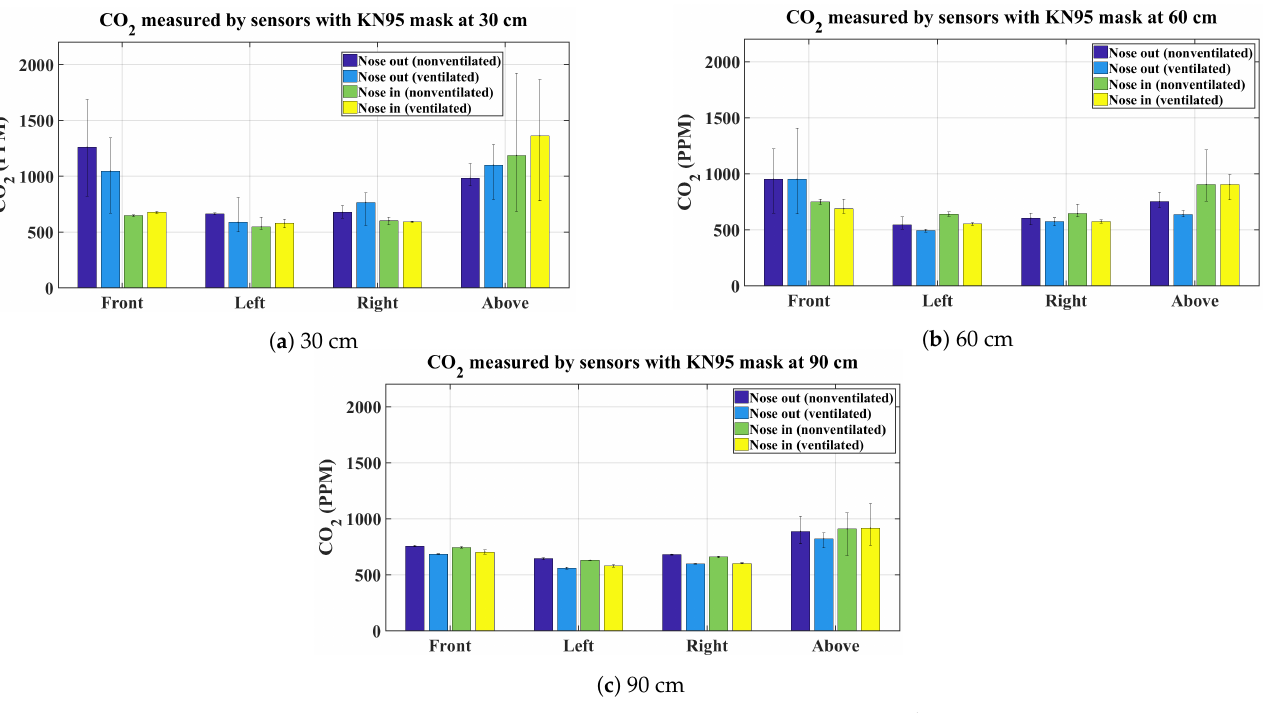
Figure 6. Average CO 2 measurements using a KN95